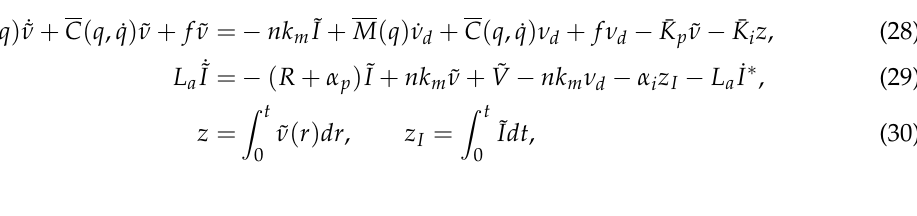
stands for either τ ∗ r or τ ∗ j l